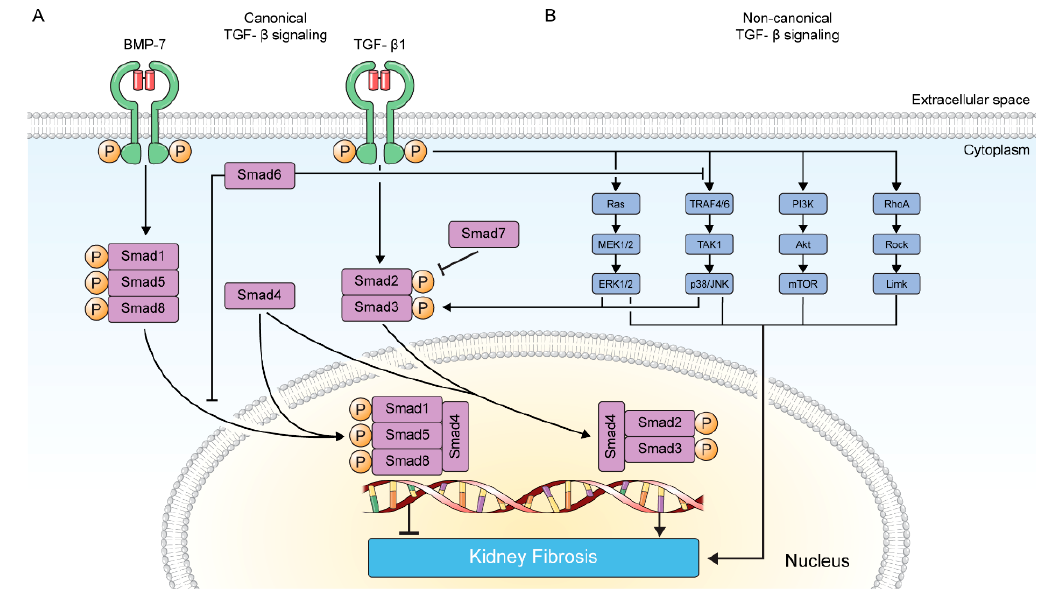
Figure 1. Canonical and Non-canonical TGF- β Signaling in Kidney Fibrosis. TGF- β binds to TGF- β receptors and induces signal transduction via canonical ( A ) and non-canonical ( B ) TGF- β signaling pathways. The canonical pathway includes TGF- β /Smad pathway. The non-canonical pathway includes MAP kinase, p38/JNK, PI3K/Akt, and RhoA GTPase signaling pathways.